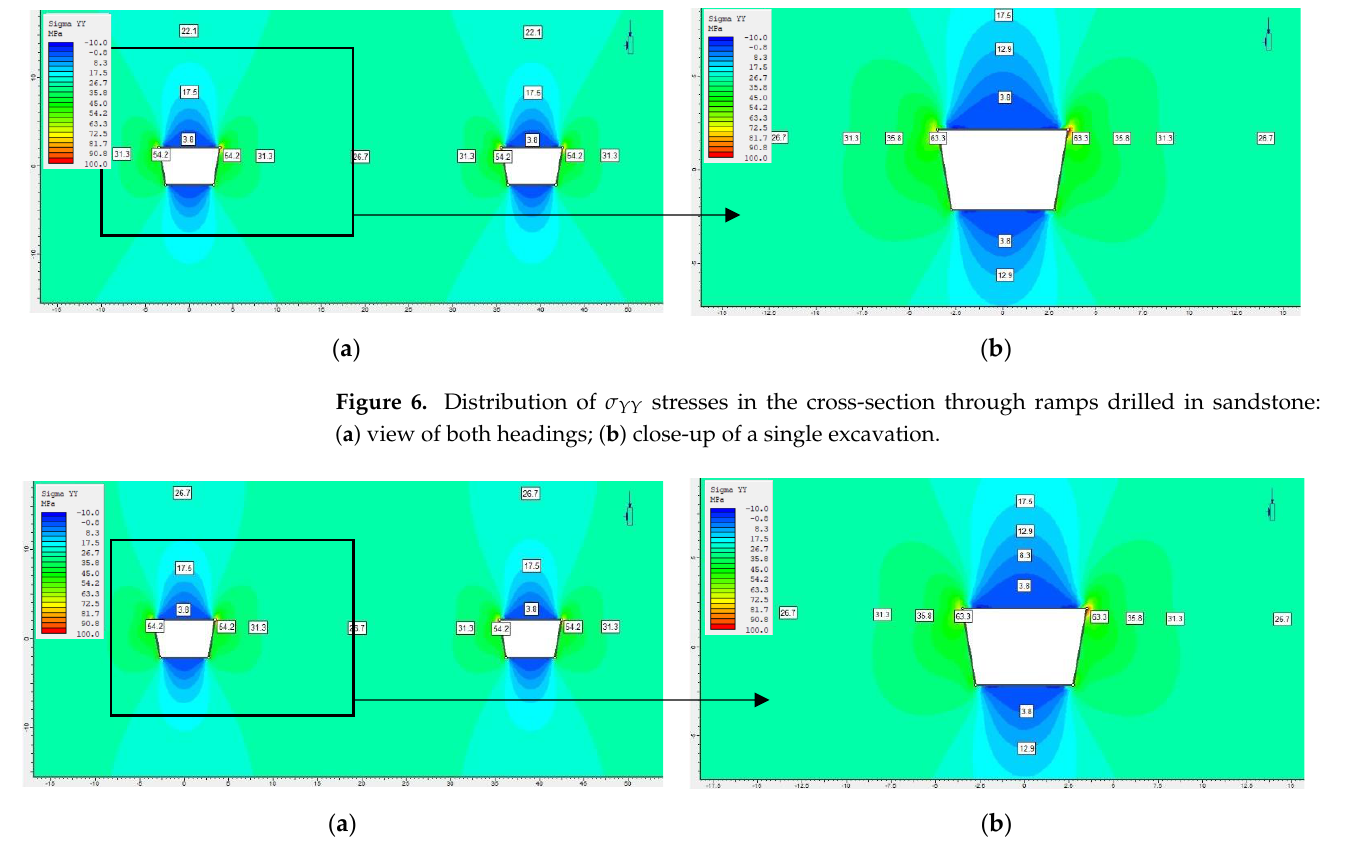
Figure 5. Distribution of σ YY stresses in the cross-section through entries drilled in: ( a ) sandstone; ( b ) dolomite.